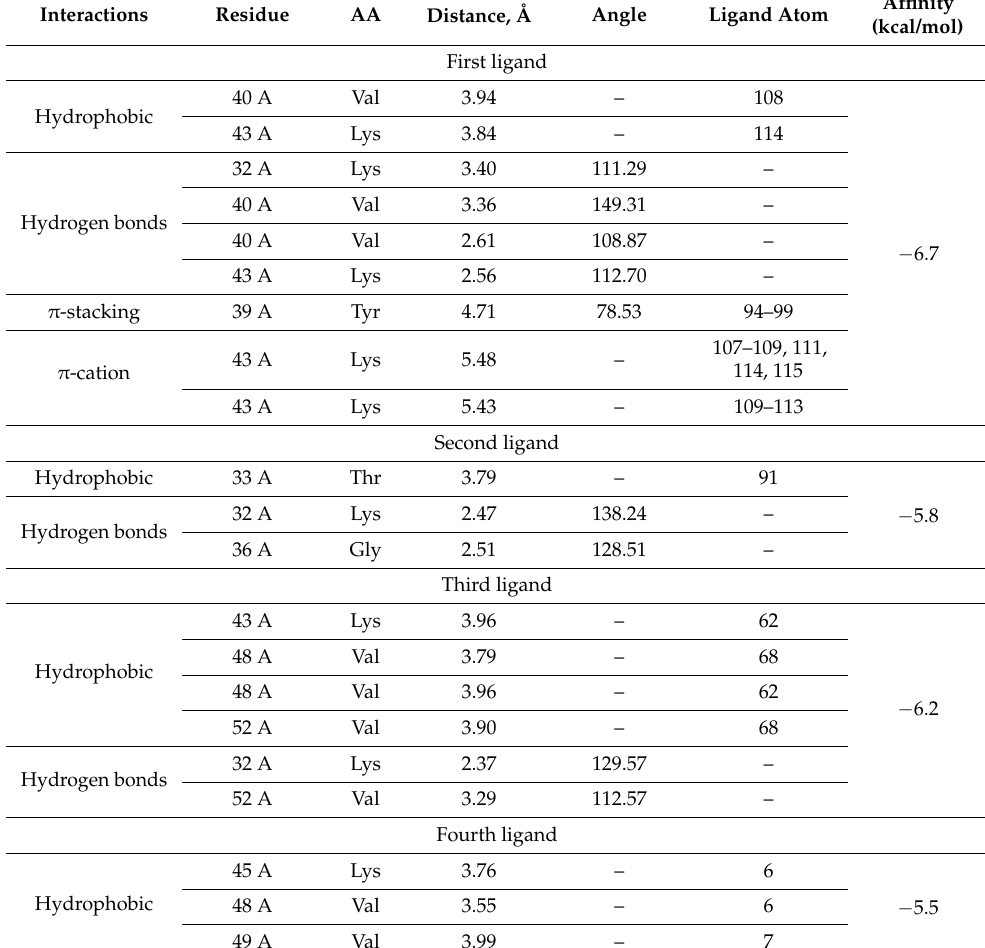
Table 2. Interactions of five Anle138b isomer ligand molecules with micelle-bound A α Syn (PDB ID 1XQ8). Interactions